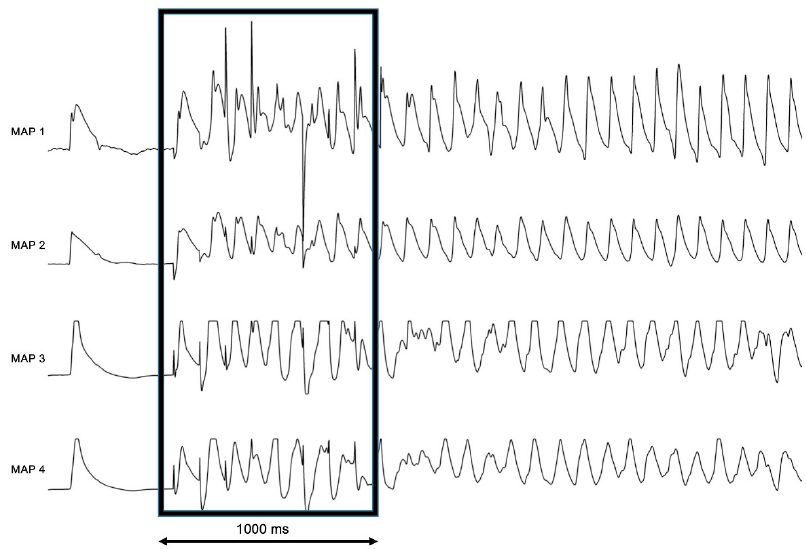
Figure 4. Representative example of the monophasic action potentials (MAP)-traces (MAP 1–4) of atrial fibrillation induced by burst pacing (box) under perfusion with isoproterenol and acetylcholine, 1000 ms for scale.